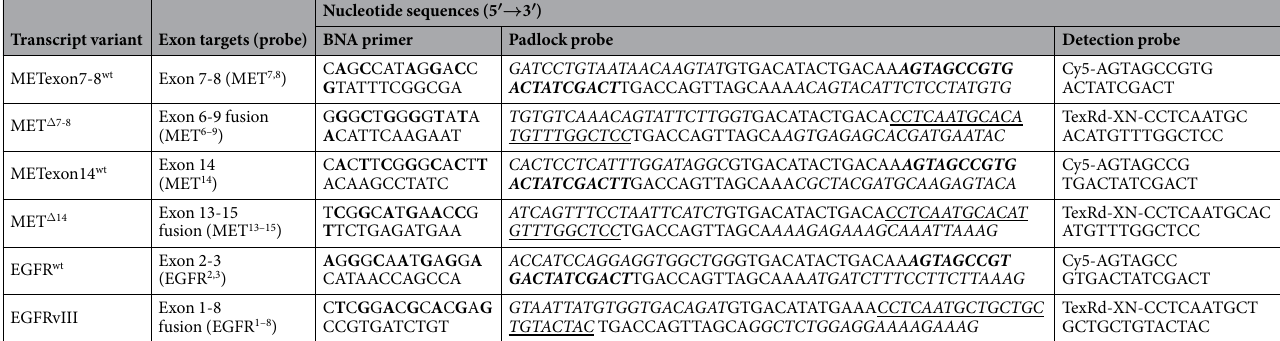
Table 2. BNA primer, padlock probe and detection probe nucleotide sequences. BNA primer Bridged Nucleic Acids are depicted in bold. Padlock probe target-specific sequences are depicted in italic. Detection probe complementary sequences in the padlock probe are coloured bold italic (wild-type) or italic underline